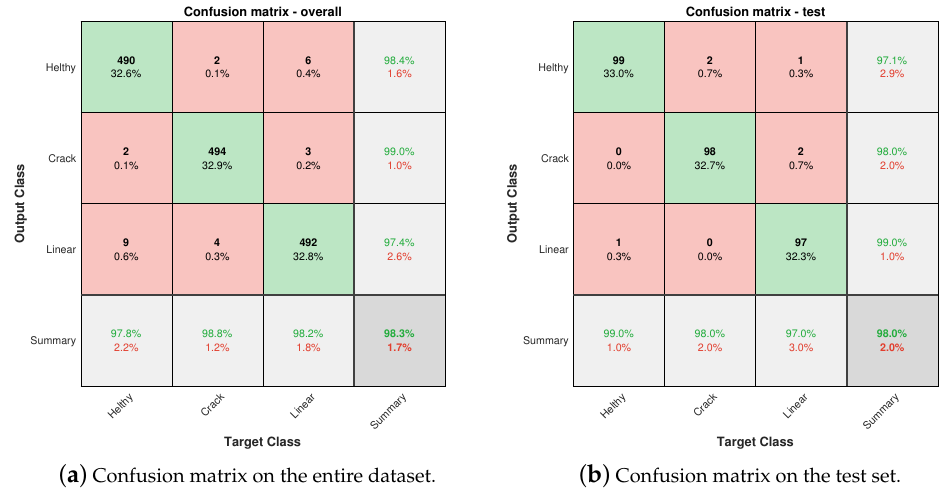
Figure 13. Performance evolution of the best neural network obtained from 25 independent trials.